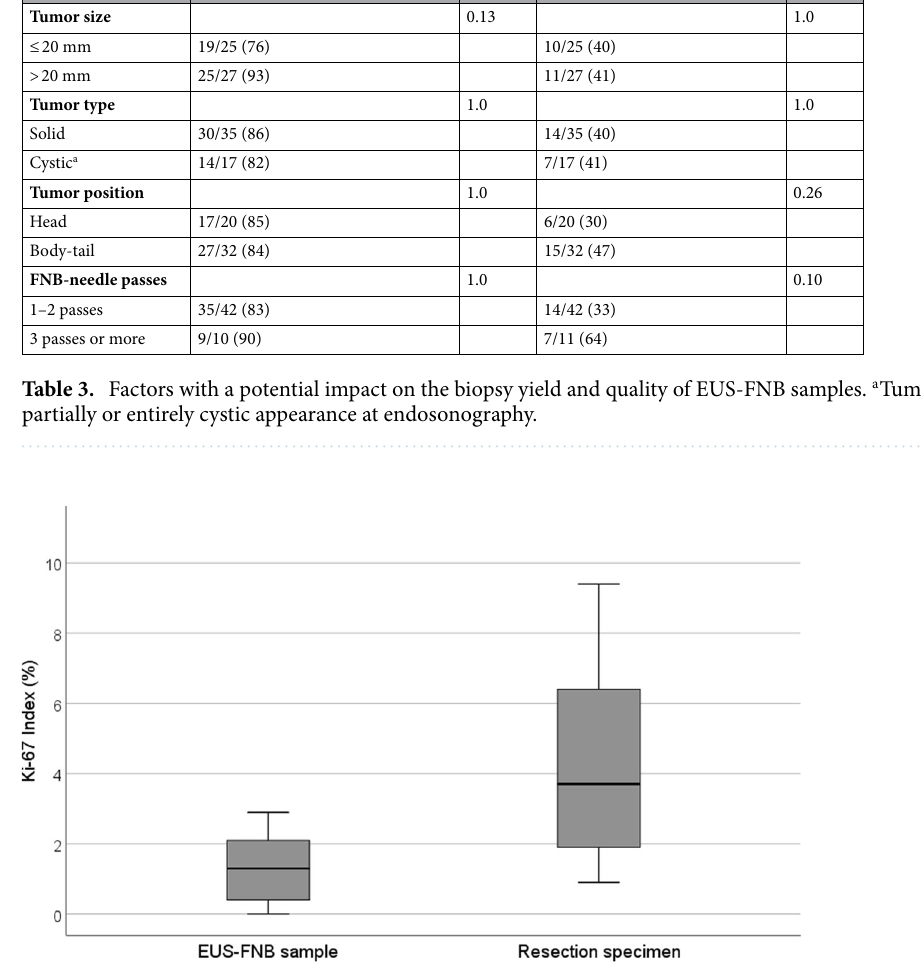
Figure 2. A box-plot of study cases subjected to surgical resection (n = 17) showing the estimated Ki-67 Index calculated in the EUS-FNB samples and the reference Ki-67 Index calculated in the corresponding resection specimens. The bold line signifies the median, the box signifies the IQR, and the T-bars signify the 95% confidence interval. The five resected cases without a corresponding, diagnostic EUS-FNB sample available for Ki-67-indexing were excluded from the plot.